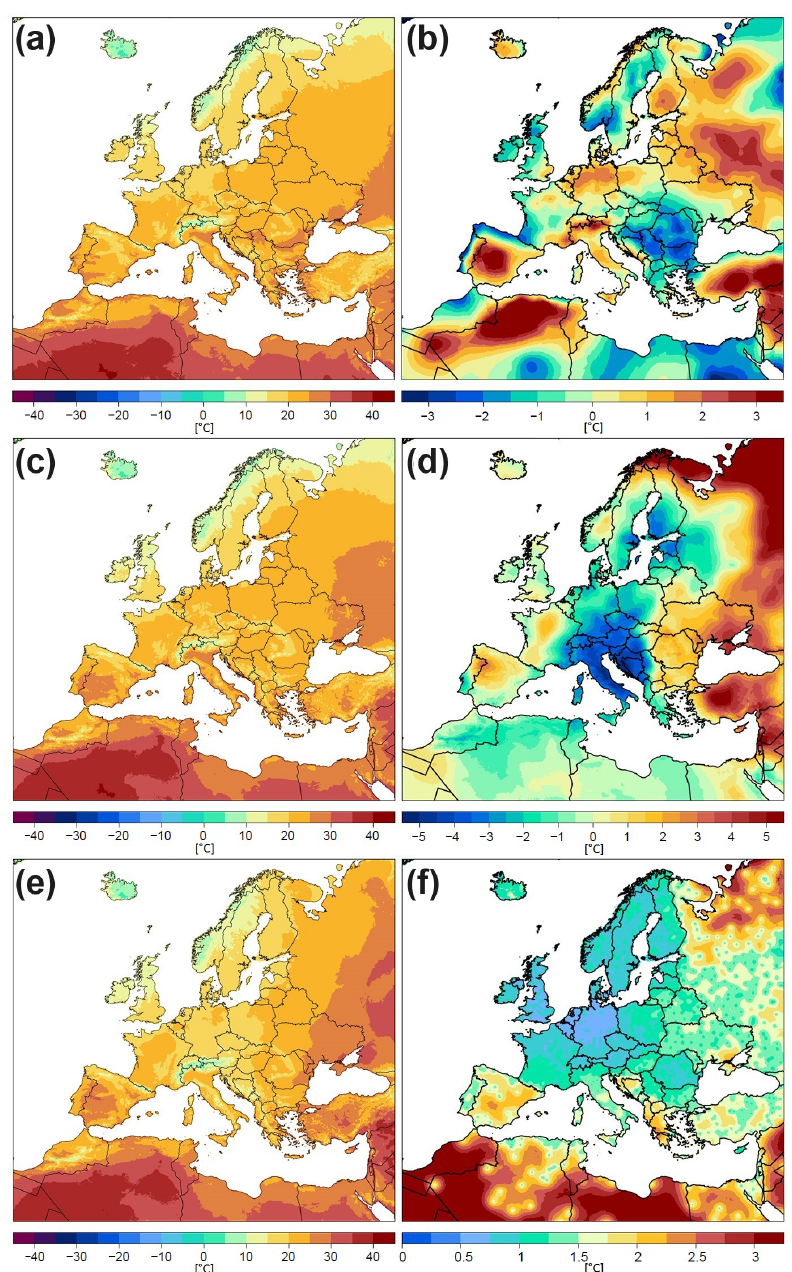
Figure 11. Steps in the interpolation of daily mean temperature for 31 July 2010. (a) Monthly regression field; (b) monthly regression residu- als; (c) monthly mean temperature; (d) daily anomaly with respect to monthly mean temperature; (e) daily mean temperature; (f) interquartile range of daily mean